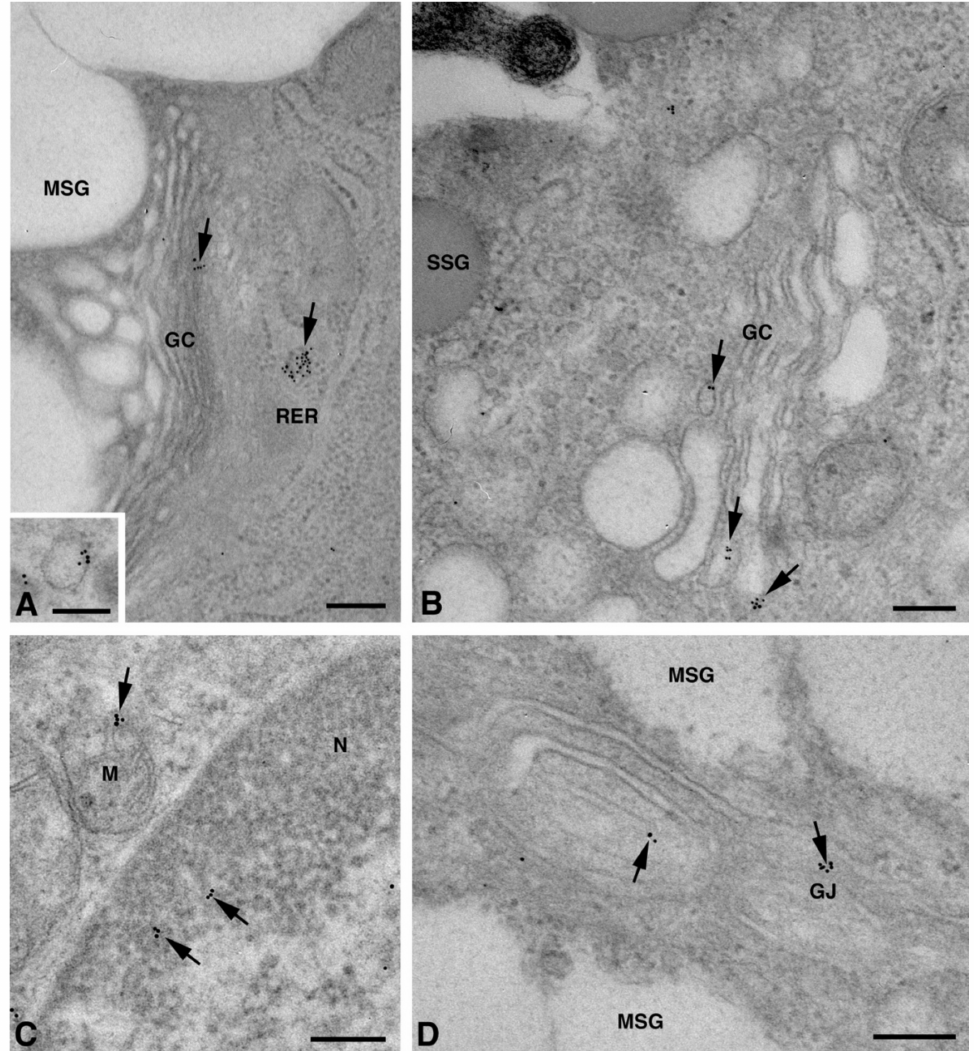
Figure 5. TEM immunogold analysis for Cx43 in NS-hLSGB. Representative images of immunore- actions (arrows) at the level of different cell compartments: rough endoplasmic reticulum, Golgi complex, and a Golgi-derived vesicle (insert) in a mucous cell ( A ), Golgi complex in a serous cell ( B ), mitochondria and nucleus in a serous cells ( C ), and GJ in the lateral plasma membranes of mucous cells ( D ). GC, Golgi complex; L, lumen; M, mitochondrium; MSG, mucous secretory granule; N, nucleus; RER, rough endoplasmic reticulum; SSG, serous secretory granule. Scale bars ( A – D ), 200 nm; ( A ) insert, 170